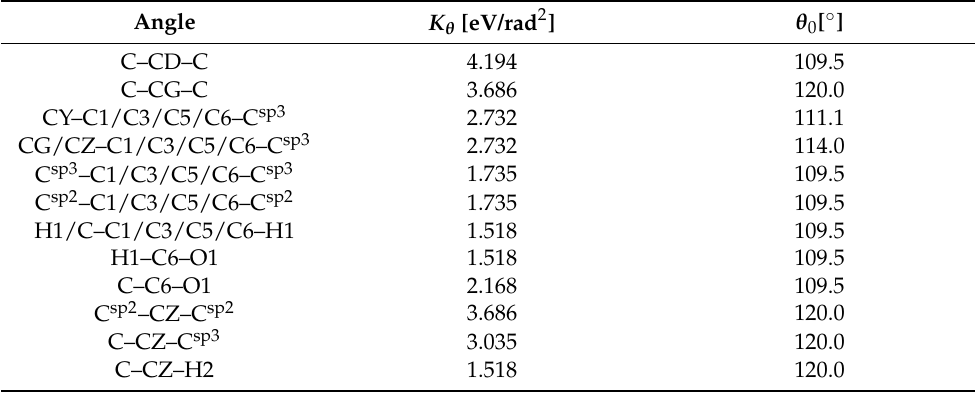
Table A3. Parameters for the harmonic angle terms of the form E angle = K θ ( θ − θ 0 ) 2 . C sp3 includes the atom types CD, C1, C3, C5 and C6. C sp2 includes the atom types CG, CZ, CY. C includes C sp3